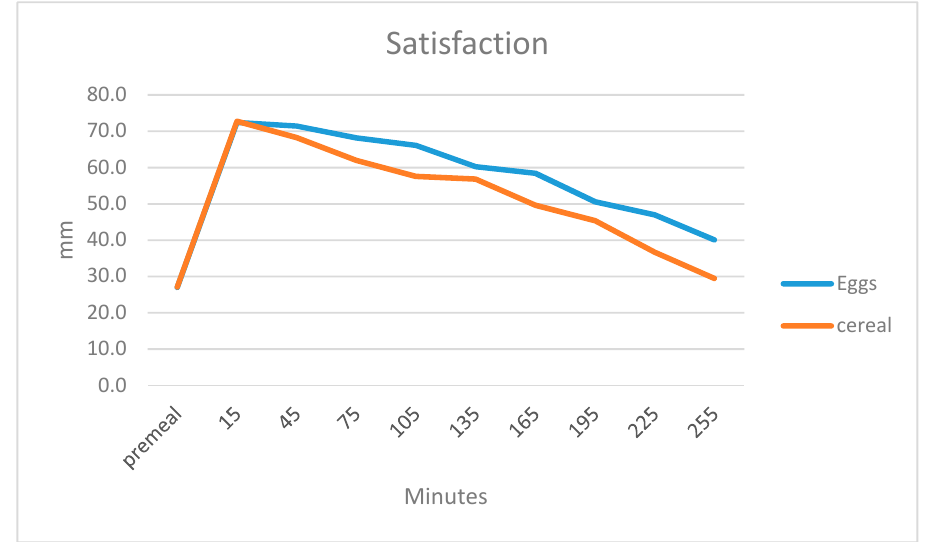
Figure 2. Subjective sensations of satisfaction before and 15, 45, 75, 105, 135, 165, 195 and 225 min after finishing breakfast on a 100-mm VAS scale.